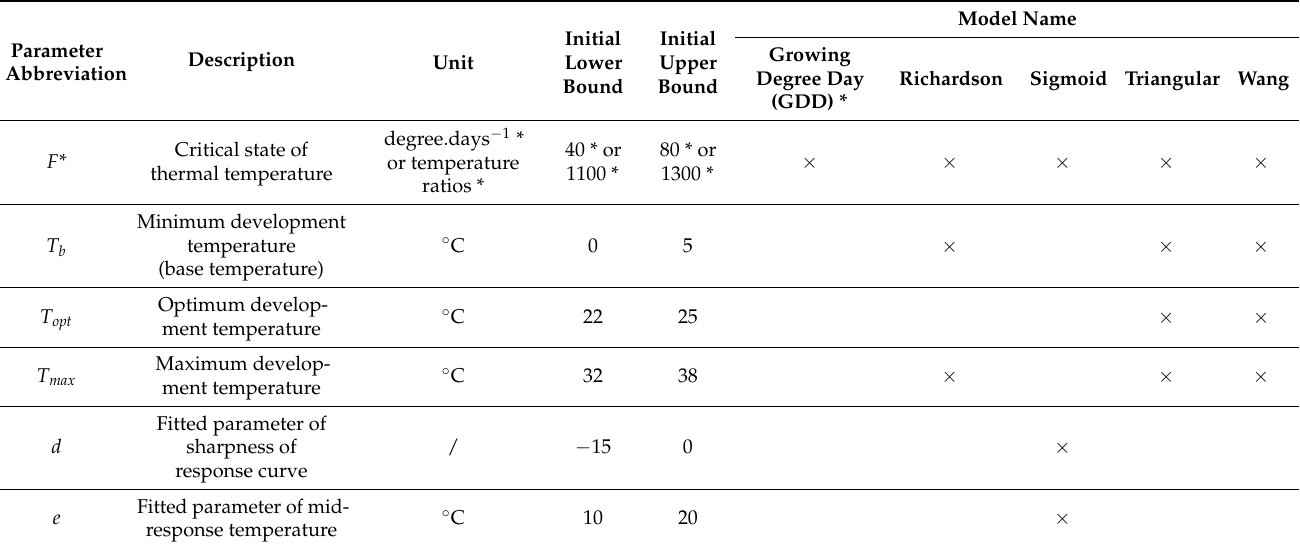
Table 2. Selected parameters of phenology models for calibration. The specified initial lower and upper boundary of uniform parameter distribution corresponds to the baseline setting. The “ × ” symbol indicates the parameter intended for the calibration of a given model. All model simulations are driven by the daily mean temperature from the first day of the year ( t 0